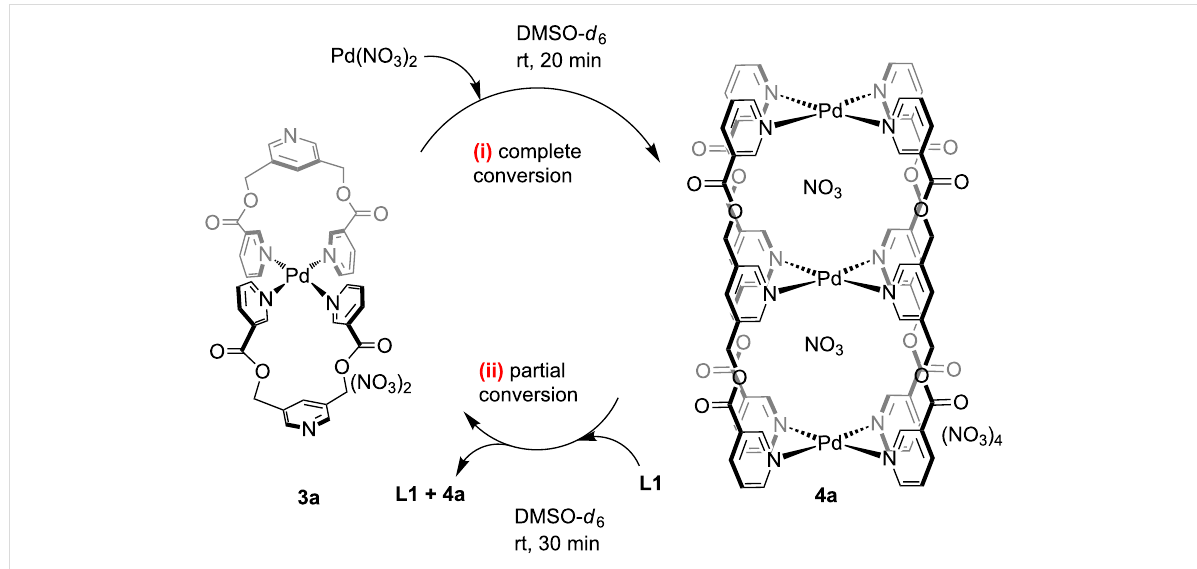
Scheme 2: Reorganization of (i) a mixture of Pd(NO 3 ) 2 and 3a at a 2:1 ratio leading to 4a with a complete conversion and (ii) a mixture of L1 and 4a at a 2:1 ratio leading to 3a but with a partial conversion.